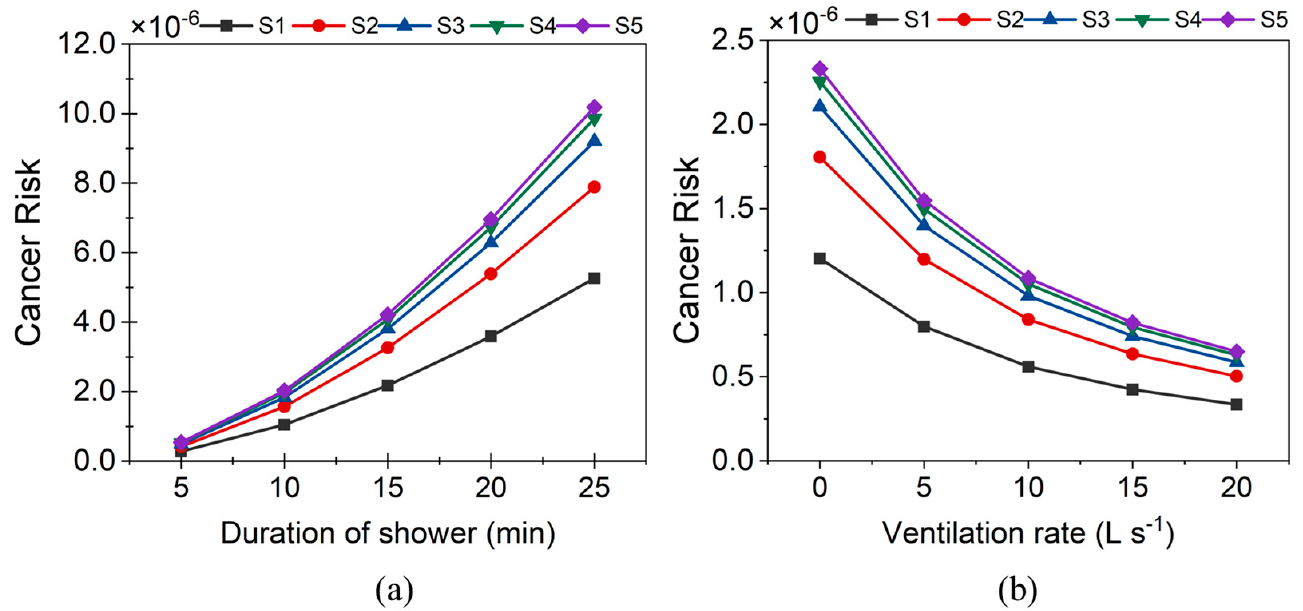
Figure 7. Effect of ( a ) showering duration and ( b ) ventilation rate on total cancer risk. With increasing shower duration, the CR was found to exponentially increase ( p = 0.001, R 2 = 0.98). For S1, S3, and S5, the CR for various shower durations was estimated as follows.